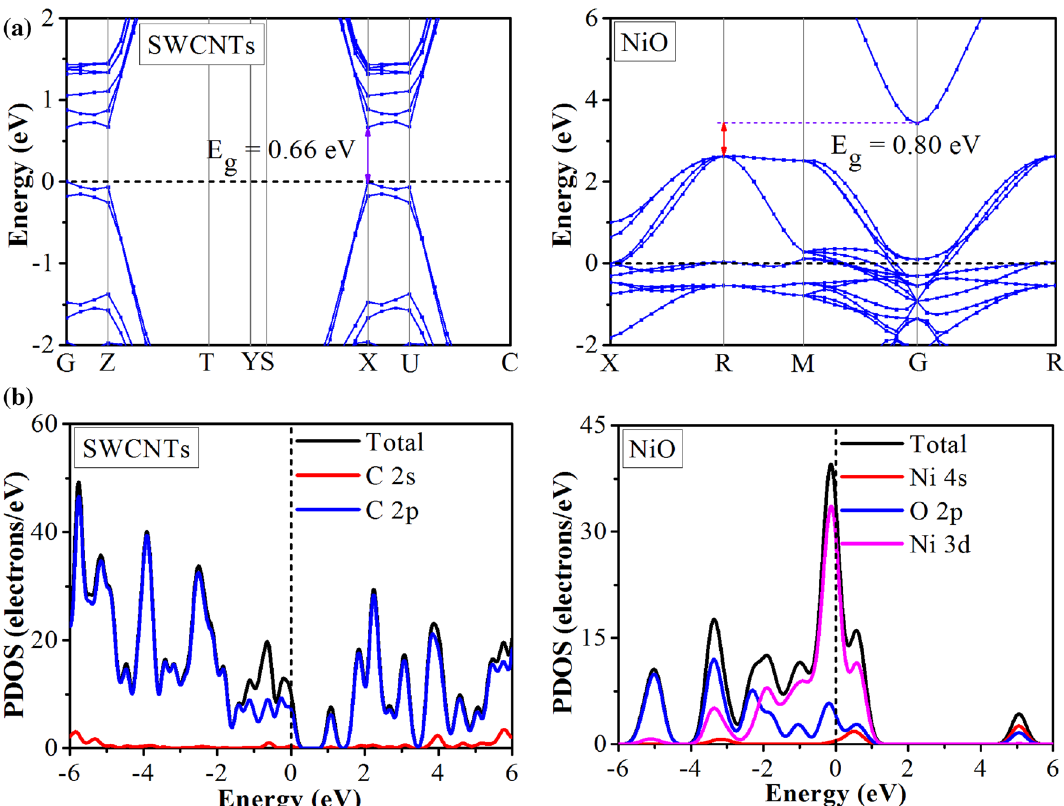
Figure 8. ( a ) Electronic band structures and ( b ) projected density of states (PDOS) of SWCNTs and NiO. The Fermi energy level was set to 0.0 eV as a black dashed line.